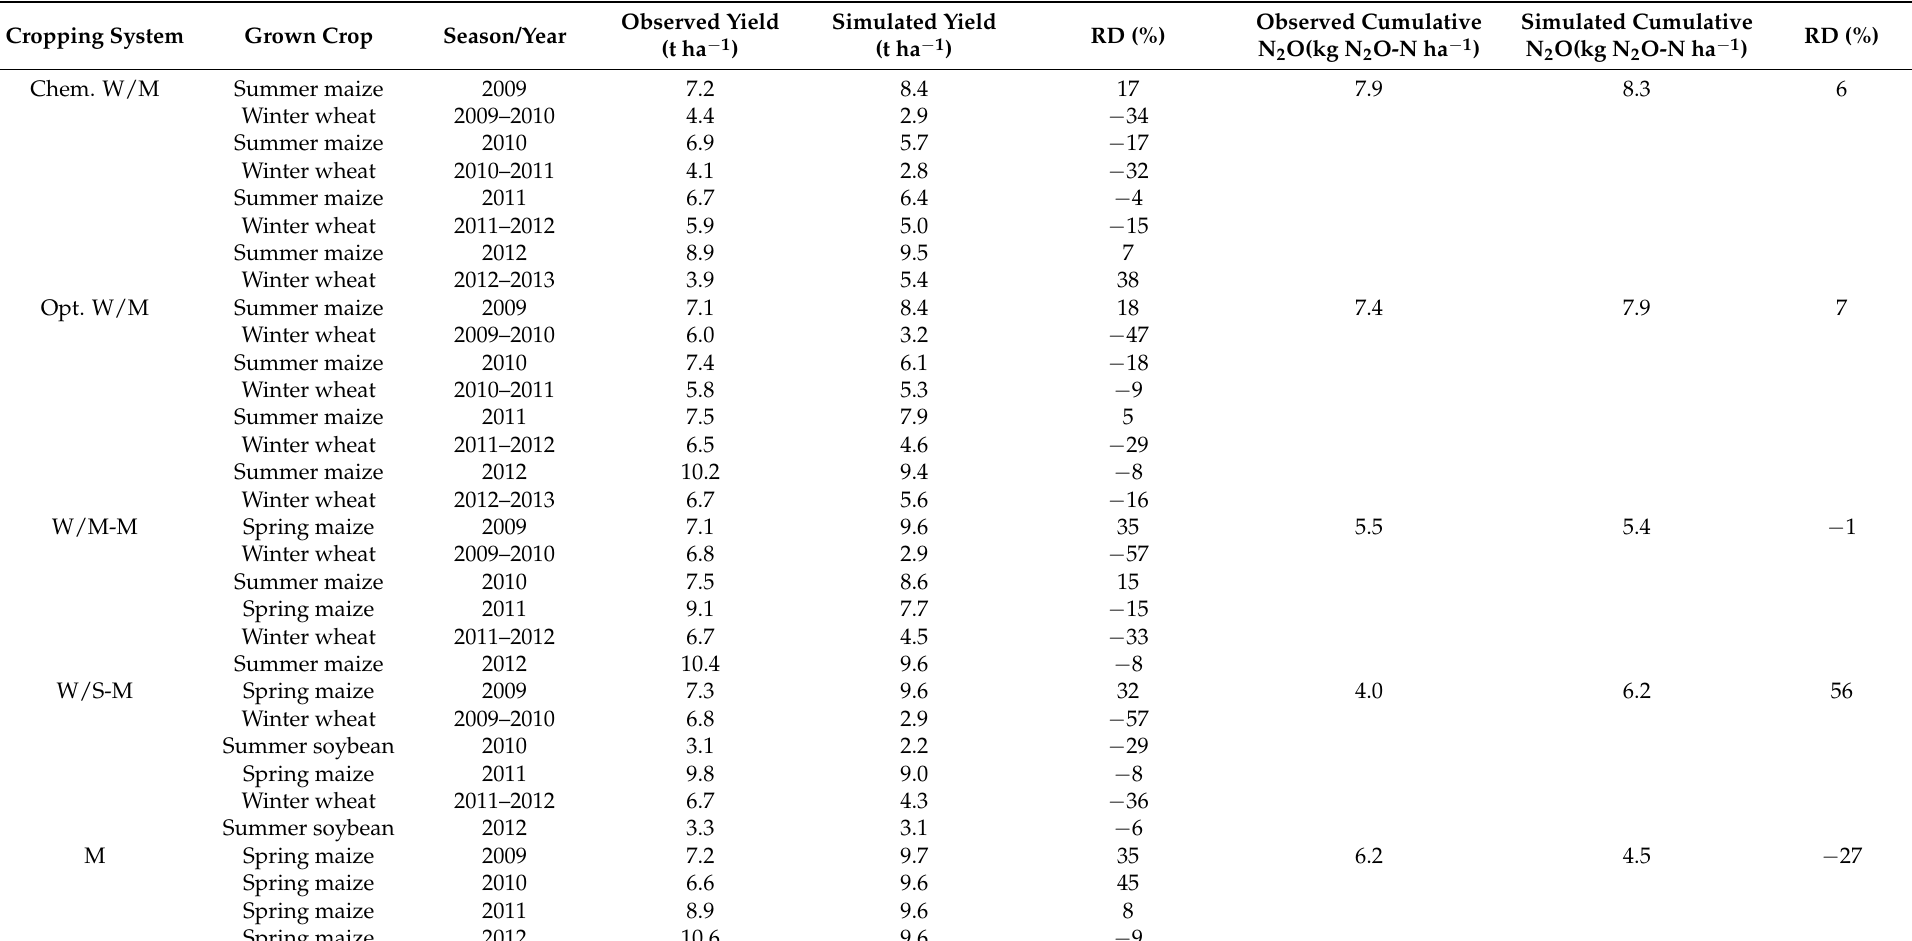
Table 2. Comparisons between the DNDC- simulated and observed annual grain yields for each crop (i.e., summer maize, winter wheat, spring maize and summer soybean) and cumulative N 2 O fluxes for the different cropping systems for